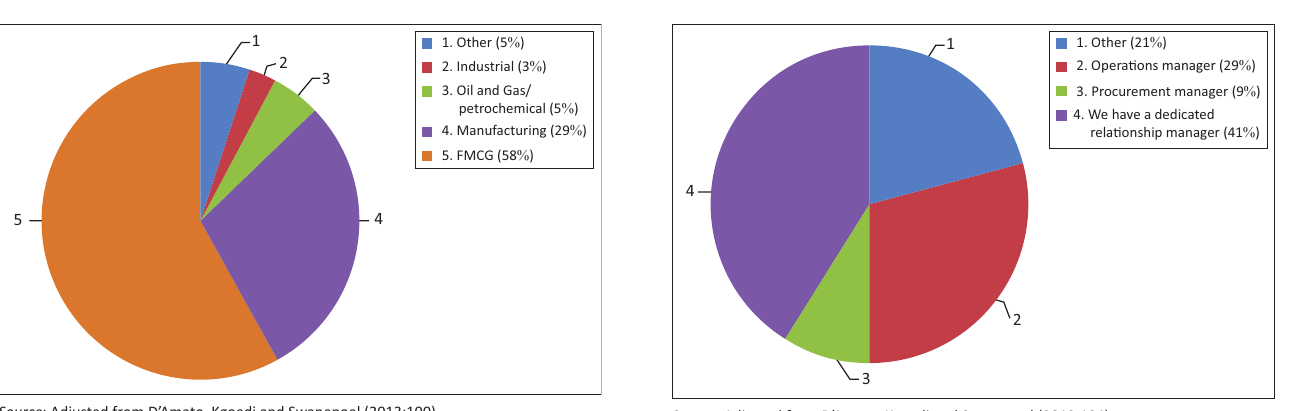
FIGURE 1: Primary industry of respondent company. FIGURE 2: Outsourcing relationship